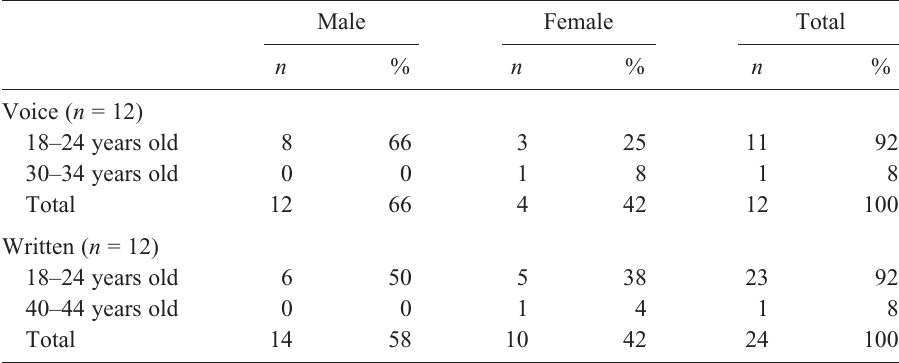
Table 2. Details of participants in streamed feedback